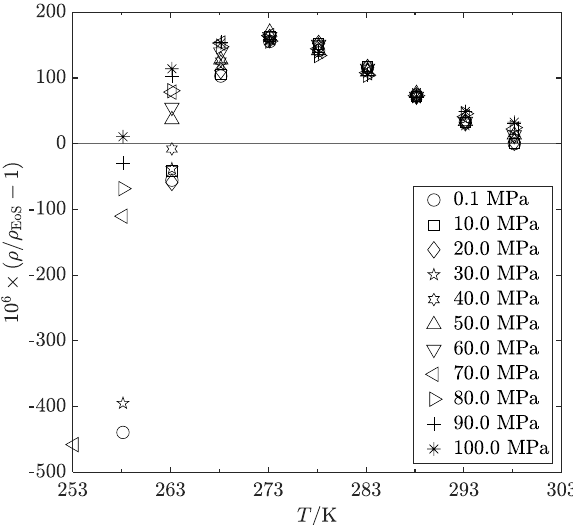
Fig. 7. Relative deviations of D 2 O densities from this work from densities calculated wtih equation of Herrig et al.[14].